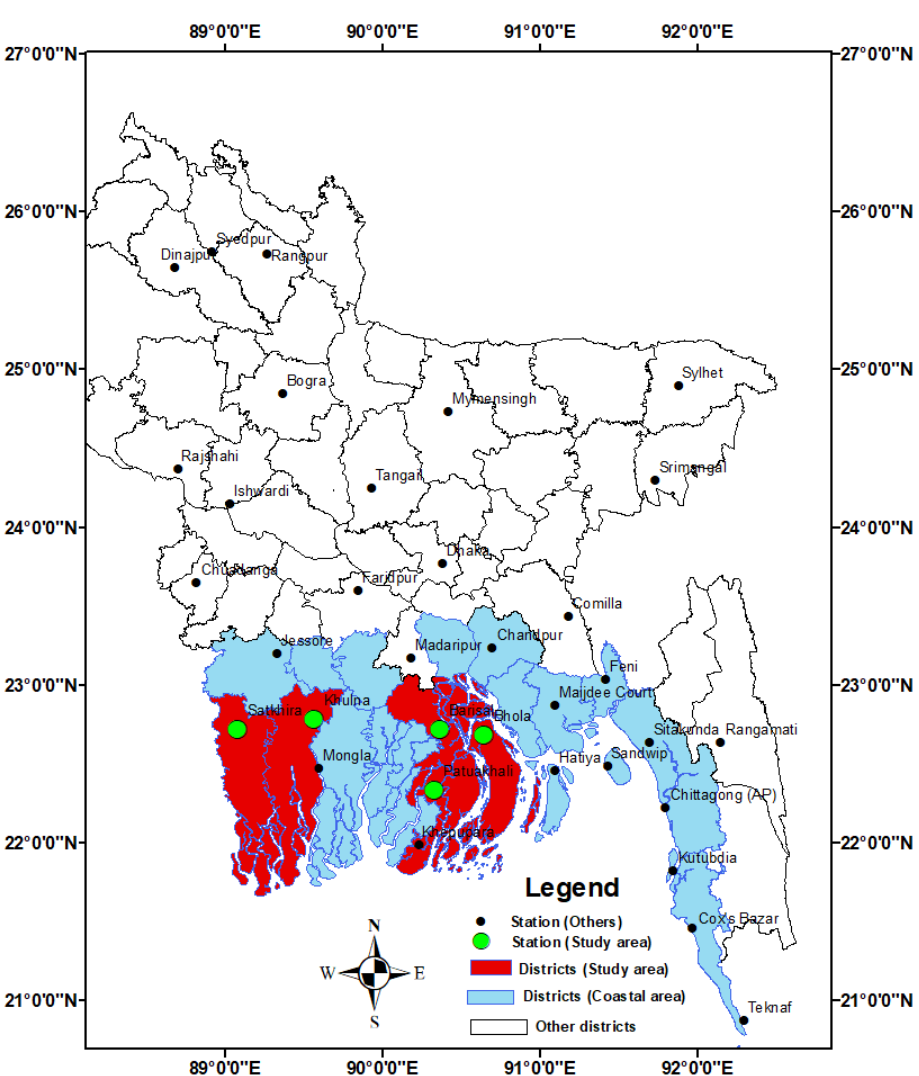
Figure 1. Map showing the observational stations of Bangladesh Meteorological Department while study areas are highlighted with red colors and other coastal districts are highlighted with lake colors.